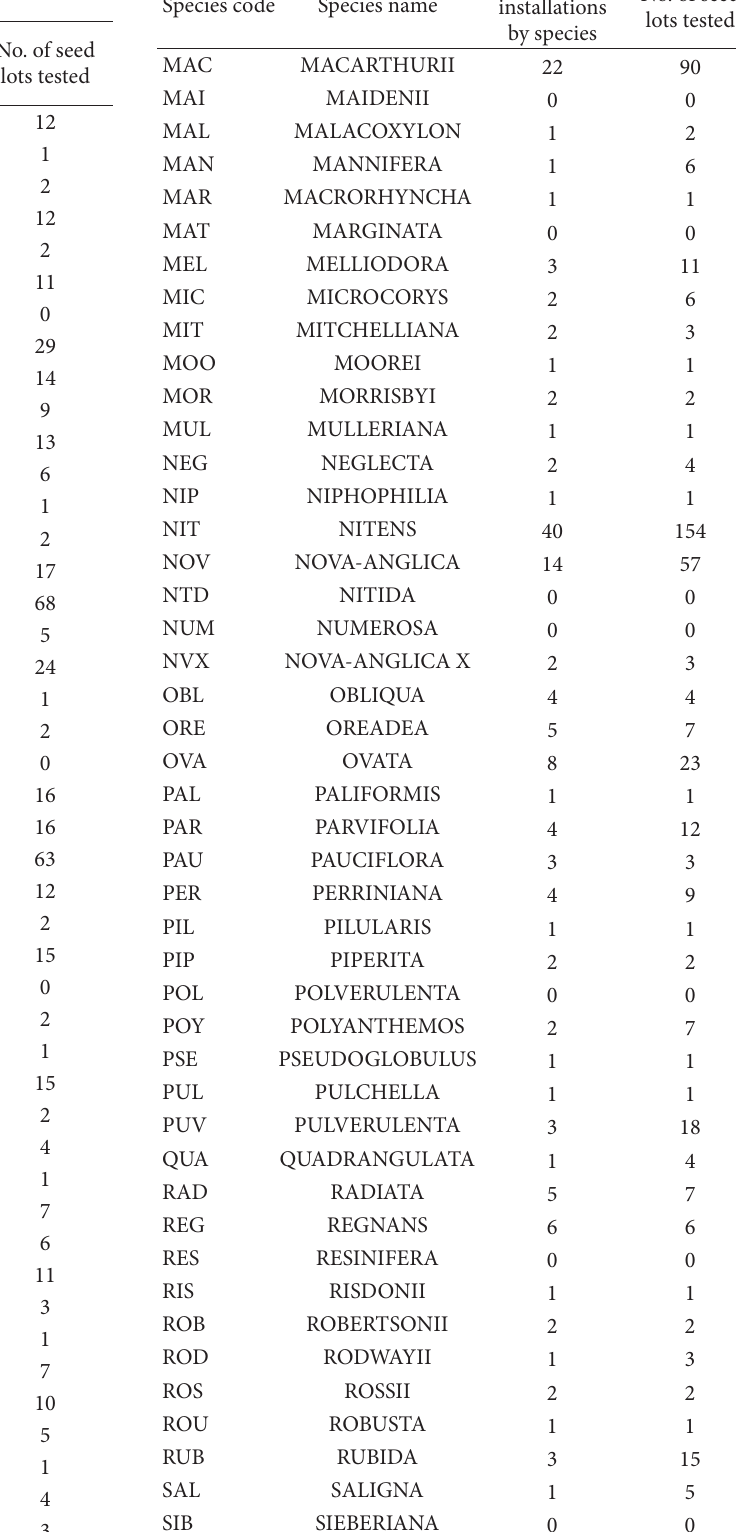
T 7: Eucalyptus seed lots tested by species and number of installation in the Lower Coastal Plain of the US South by members of the Hardwood Research